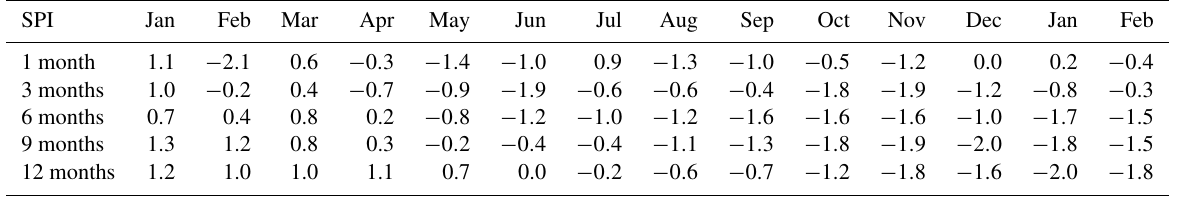
Table 2. SPI meteorological drought intensity values for different periods derived from historical precipitation distribution. SPI